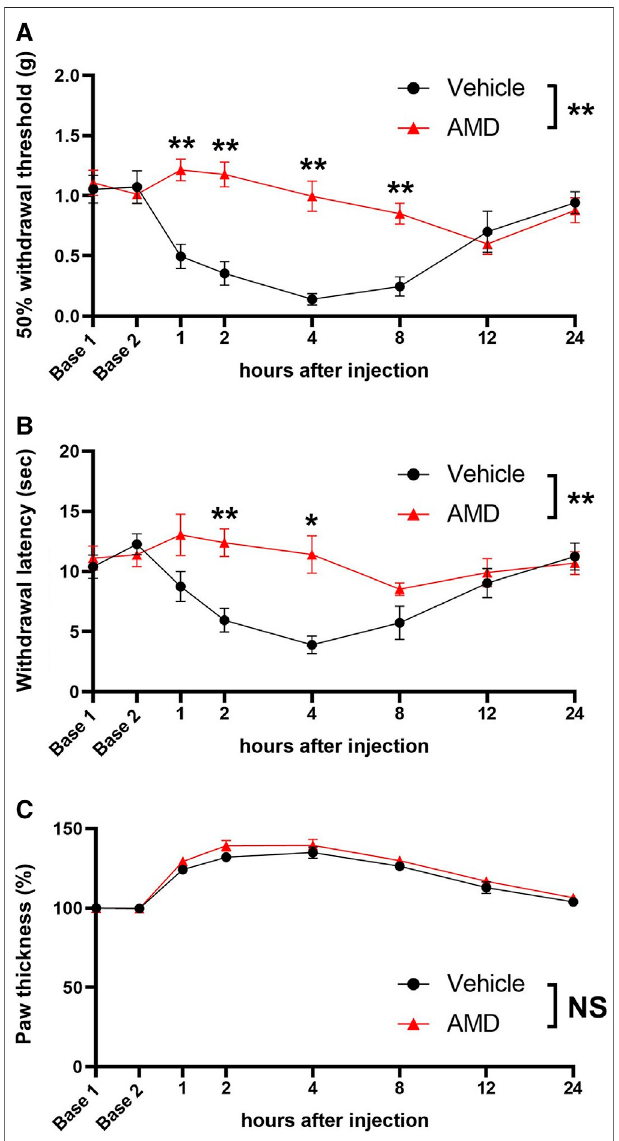
FIGURE 2 | Mechanical and thermal sensitivity and paw thickness after zymosan injection. (A) 50% withdrawal threshold values based on the von Frey test with the up-down method. (B) Thermal withdrawal latency assessed by the Hargreaves test. (C) Paw thickness after zymosan injection AMD: amiodarone * p < 0.05 vs. vehicle; ** p < 0.01 vs. vehicle.